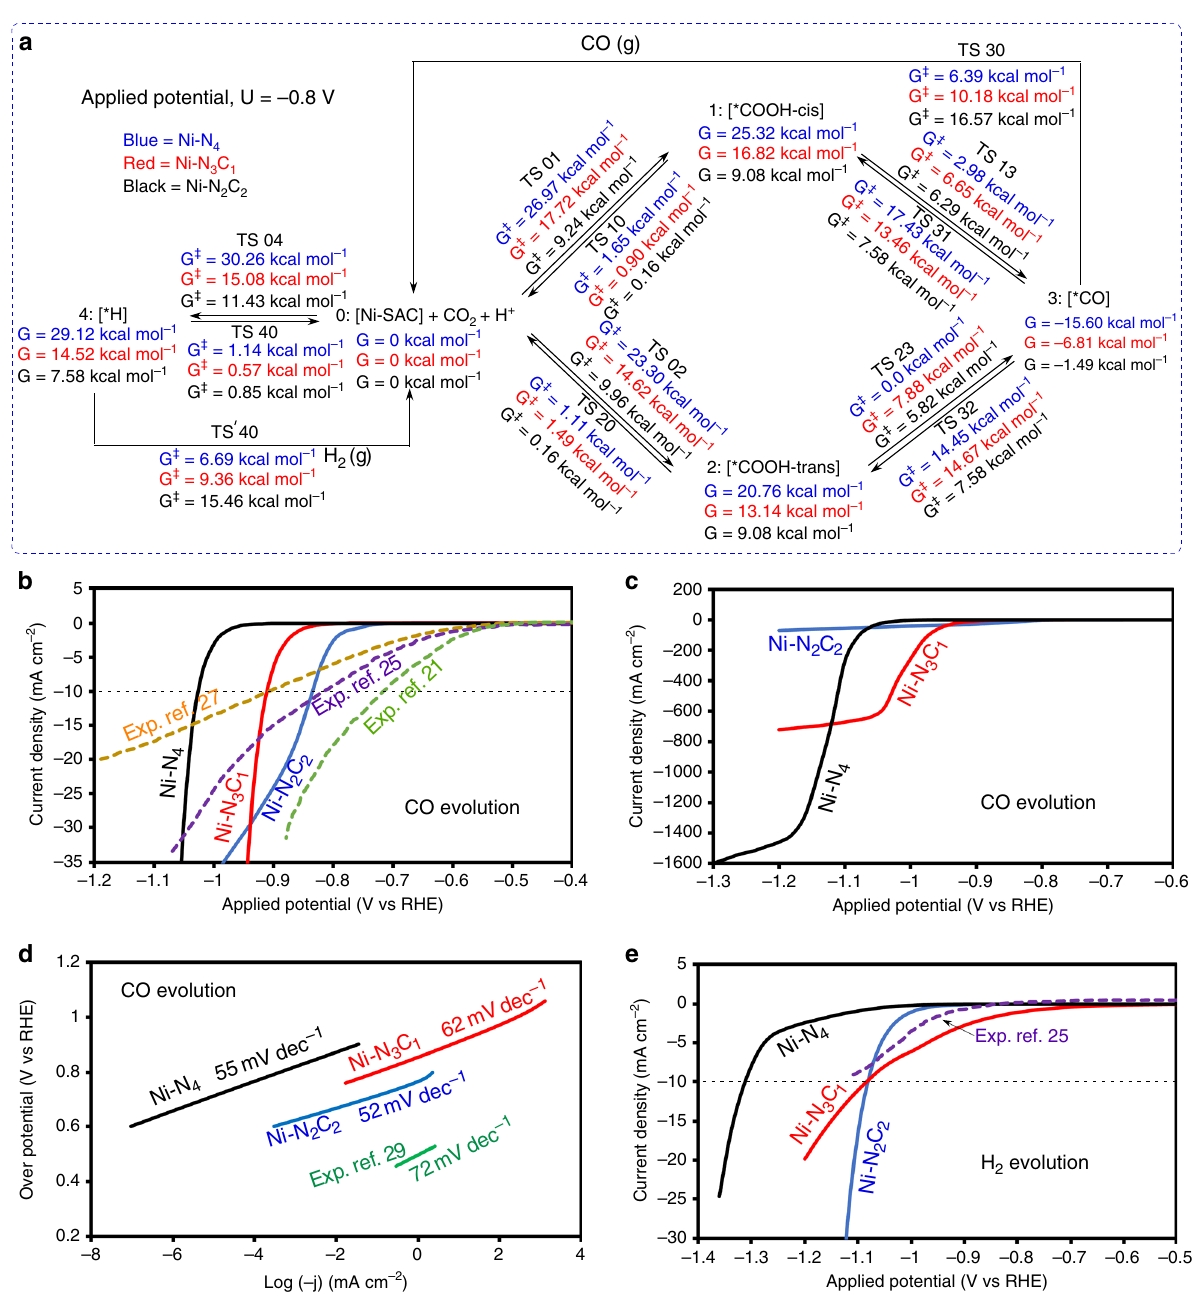
Fig. 7 QM derived free energies and predicted reaction kinetics. a Schematic representation of free energies at 298 K and pH 7 for − 0.8 V applied potential. This summarizes all reaction intermediates (0 – 4) and transition state (TS) free energies involved in the reduction of CO 2 on nickel single site at − 0.8 V constant applied potential. (Blue: Ni – N – N – N 4 , Red: Ni 3 C 1 and Black: Ni 2 C 2 surface). b Calculated partial current densities for CO evolution during CO 2 reduction on Ni – N 2 C 2 (blue curve), Ni – N 3 C 1 (red curve) and Ni – N 4 (black curve) along with experimental data from refs. 21,25,27 (dotted curve) for comparison (equivalent number of nickel atoms). c Large partial current densities for CO evolution during CO 2 reduction on Ni – N 2 C 2 (blue curve), Ni – N 3 C 1 (red curve) and Ni – N 4 (black curve). d Tafel slopes calculated from the I – V curves for CO evolution on Ni – N 2 C 2 (blue line), Ni – N 3 C 1 (red line) and Ni – N 4 (black line) during CO 2 reduction, showing good agreement with the Tafel slope from experiment (green line). e Calculated partial H 2 current densities as a function of applied potential during CO 2 reduction on Ni – N 2 C 2 (blue curve), Ni – N 3 C 1 (red curve) and Ni – N 4 (black curve) along with experimental data from ref. 25 (dotted curve) for comparison (equivalent number of nickel atoms), at pH 7 and 298